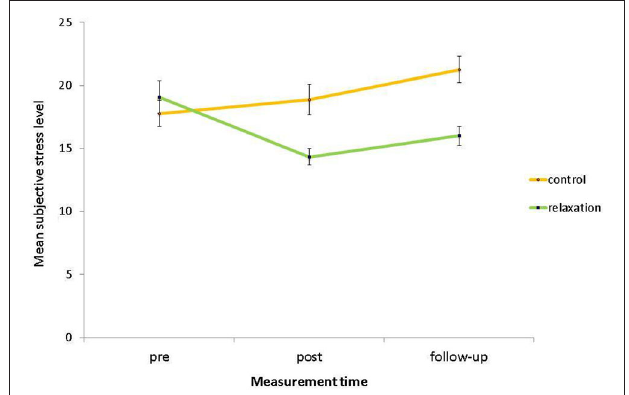
FIGURE 1 | Mean subjective stress levels, i.e., baseline assessment (pre), after the intervention (post), and after the PM task (follow-up) as a function of relaxation condition. Bars represent standard errors.